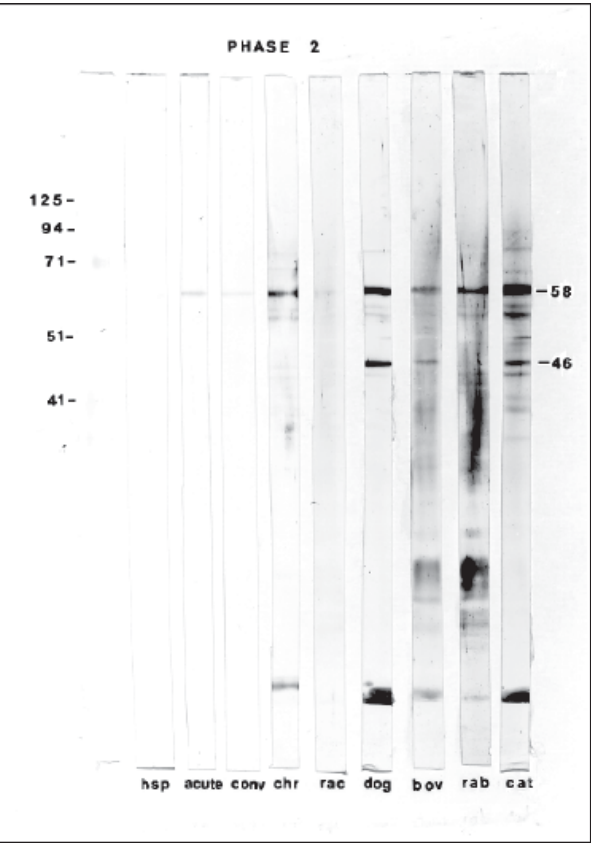
Figure 2) Western immunoblots showing immunoglobulin G antibod- ies directed against various antigens of phase II Coxiella burnetii cells.